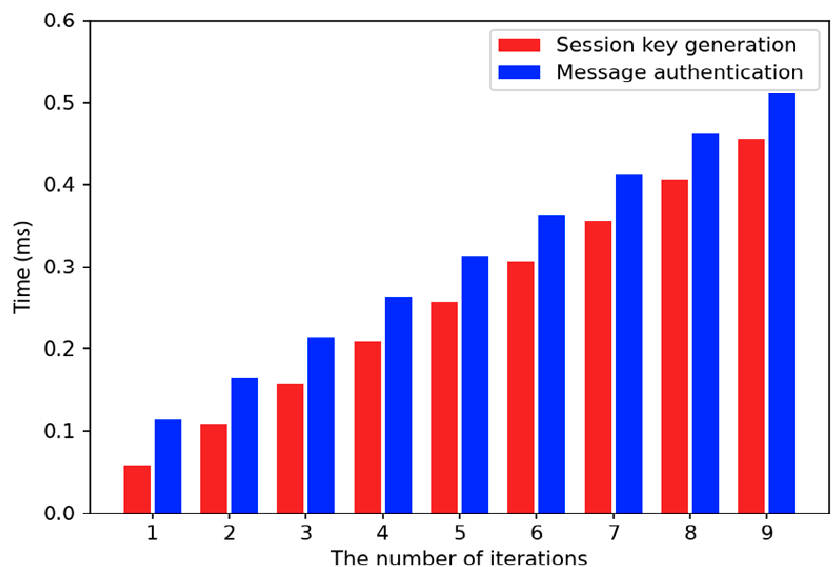
Figure 8. Time taken to verify the CAN message and update a gateway-initiated session as a function of iterations of a given hash function.